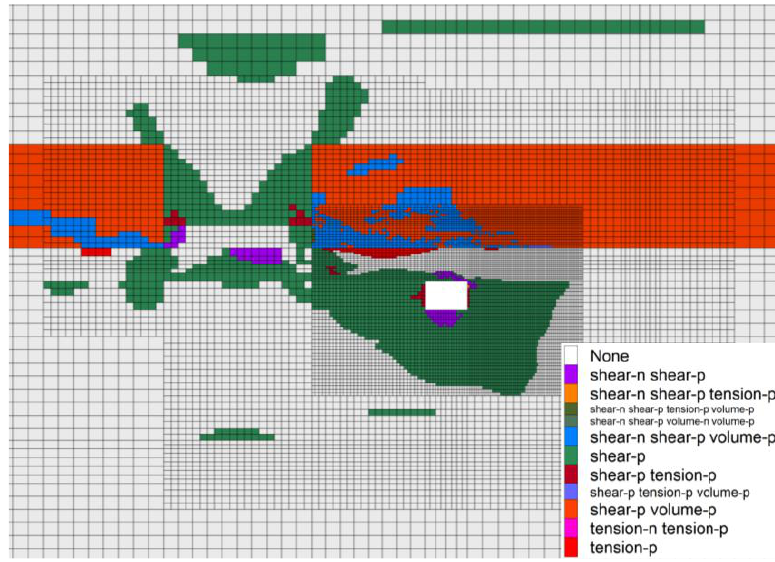
Figure 8. Plastic zone distribution cloud map when the roadway excavation along the roof.